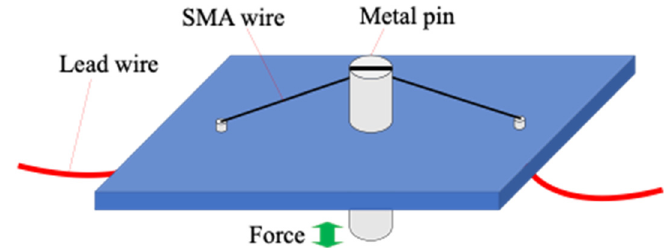
Table 1. Physical properties of BMF75.